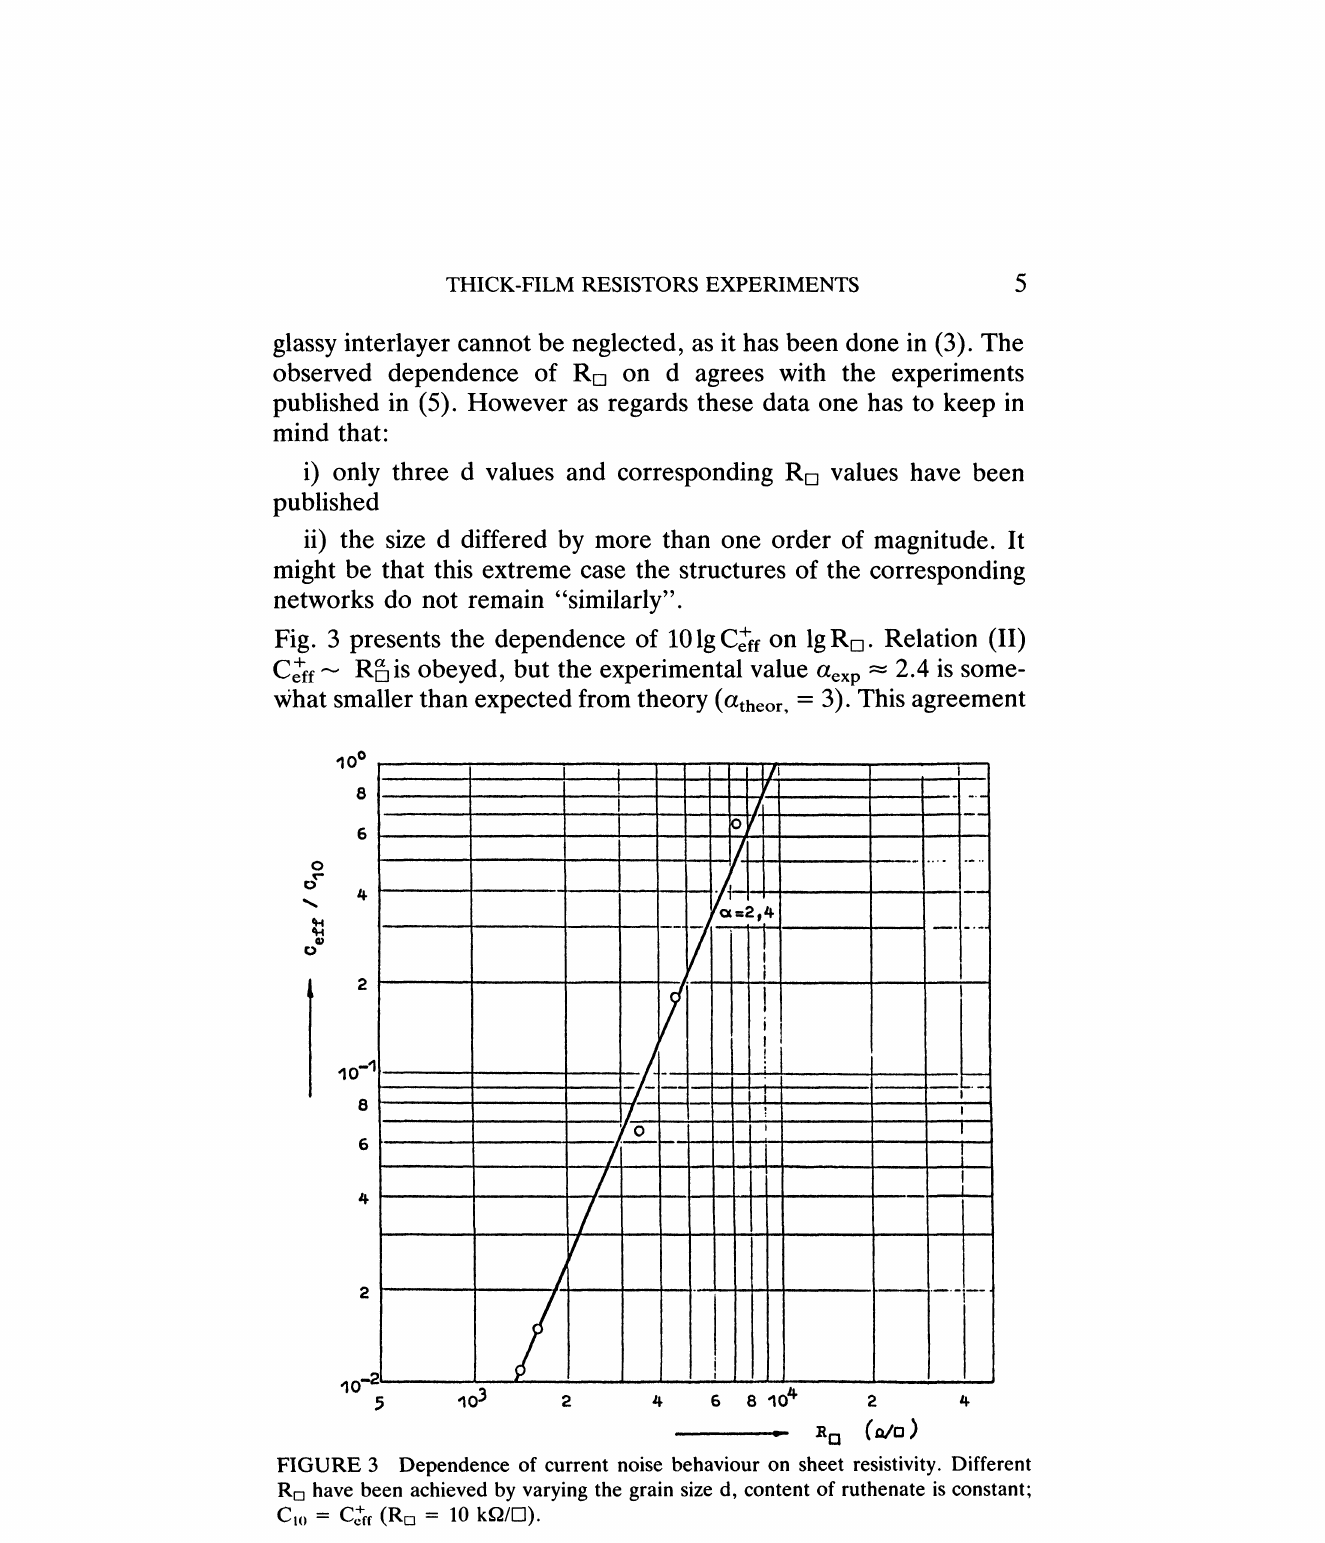
FIGURE 3 Dependence of current noise behaviour on sheet resistivity.